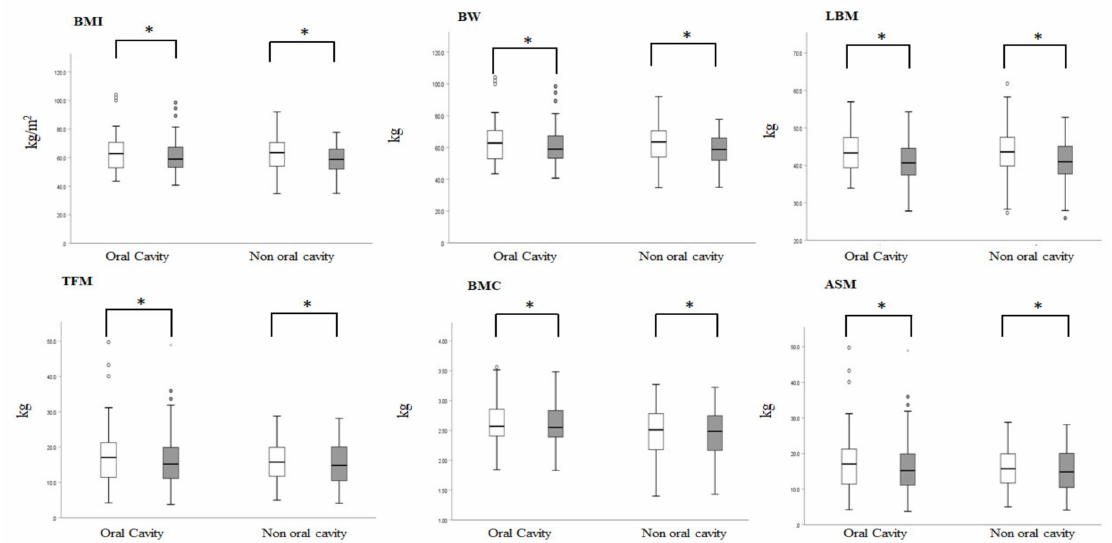
Figure 2. Box plots show the values of BMI, BW, and body composition parameters (LBM, TFM, BMC, ASM) at CCRT start (open box) and CCRT end (close box) in oral cavity cancer and non-oral cavity cancer. * denotes p < 0.05, considered significance between start and end. BMI, body mass index; BW, body weight; LBM, lean body mass; TFM, total fat mass; BMC, bone mineral content; ASM, appendicular skeletal mass; CCRT, concurrent